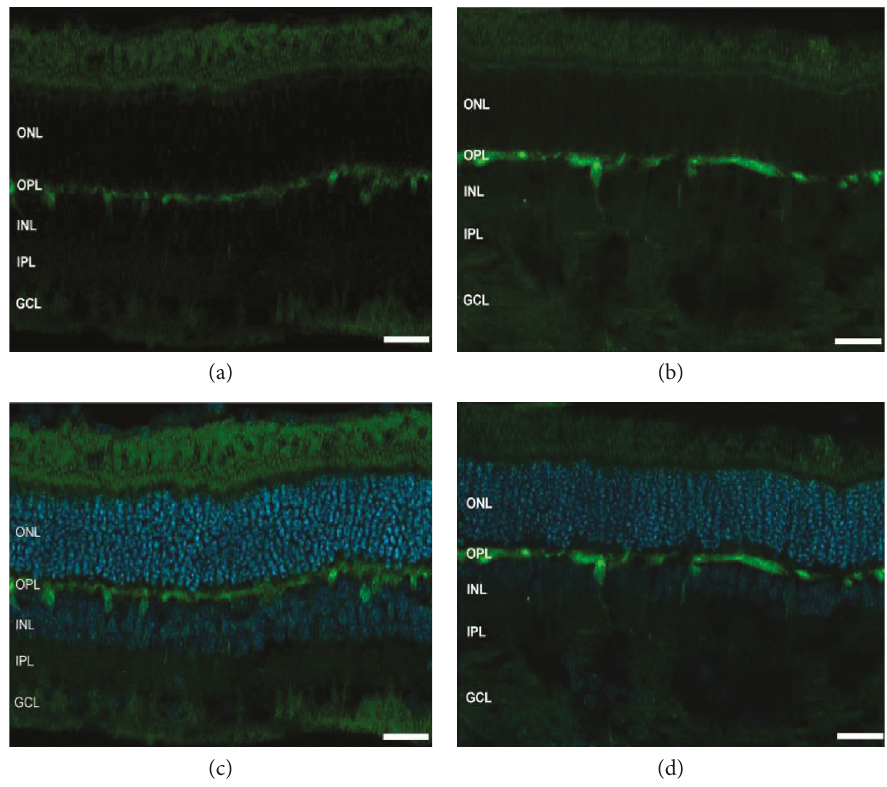
Figure 10: Expression pattern of horizontal cells in the control and experimental retinas. Representative images of the control retinal sections ((a) and (c) and detached retinas ((b) and (d)) labelled for calbindin (green) and counter stained with DAPI (blue). IS =inner segment, OS=outer segment, ONL =outer nuclear layer, INL =inner nuclear layer, OPL =outer plexiform layer, INL =inner nuclear layer, IPL =inner plexiform layer, and GCL=ganglion cell layer. Original magni fi cation ×